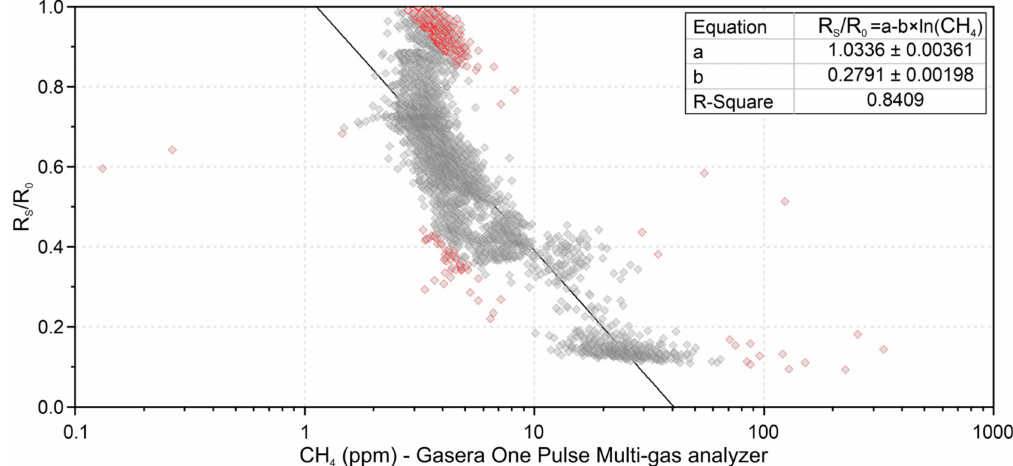
Figure 9. TGS2600 intercomparison curve with a Gasera One Pulse gas analyzer. The points marked in red correspond to the identified outliers, which were not considered for the construction of the